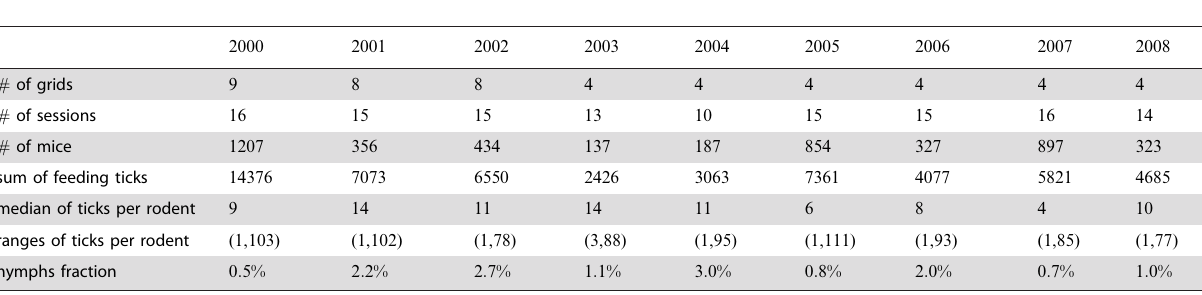
Table 1. Basic descriptive statistics for empirical data.